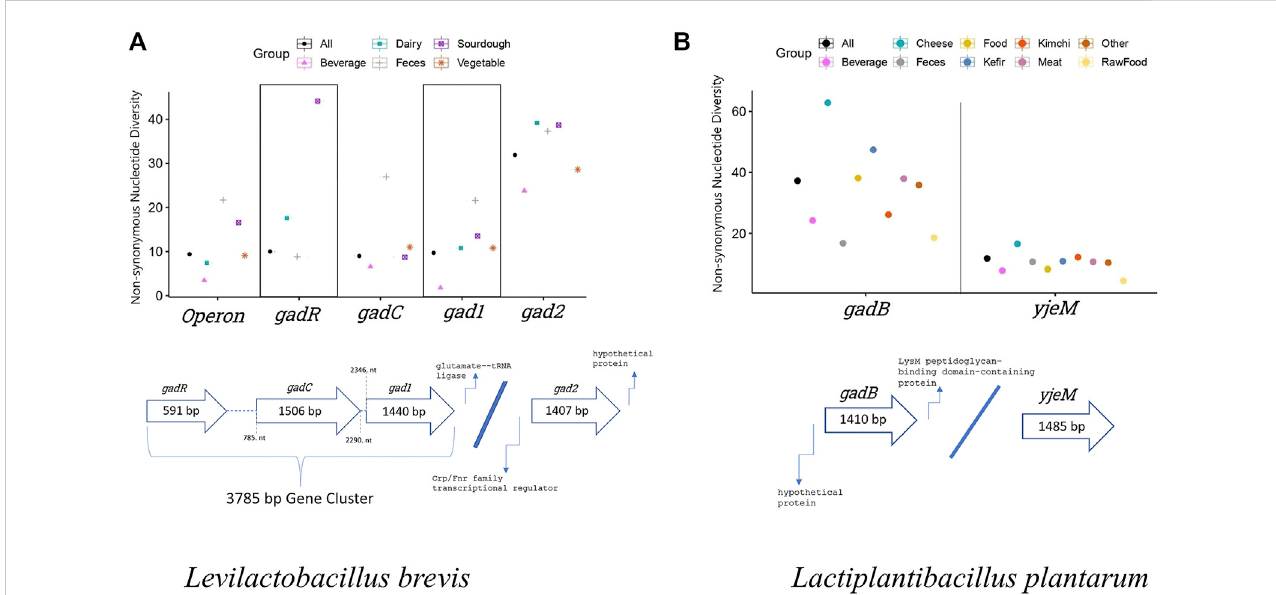
FIGURE 1 Non-synonymous nucleotide diversity estimates of GAD pathway genes from (A) L. brevis ( n = 30), and (B) L. plantarum ( n = 88) considering all samples, and indivudual populations isolated from different environments. Detailed sample size and other population genetic parameter estimates for L. brevis and L. plantarum populations are presented in Supplementary Tables S5, S6, respectively. Thick arrows show the GAD pathway gene organiation in L. brevis and L. plantarum genomes. Numbers inside the thick arrows show the length of each gene in base pairs (bp). Numbers outside the arrows indicate the relative nucleotide number (nt) positions of genes with respect to each other. gadR , Transcription regulator gene; gadC and yjeM , glutamate/GABA transporter gene; gad1 , gad2 , and gadB , glutamate decarboxylase enzyme gene. L. brevis operon includes gadR , gadC , and gad1